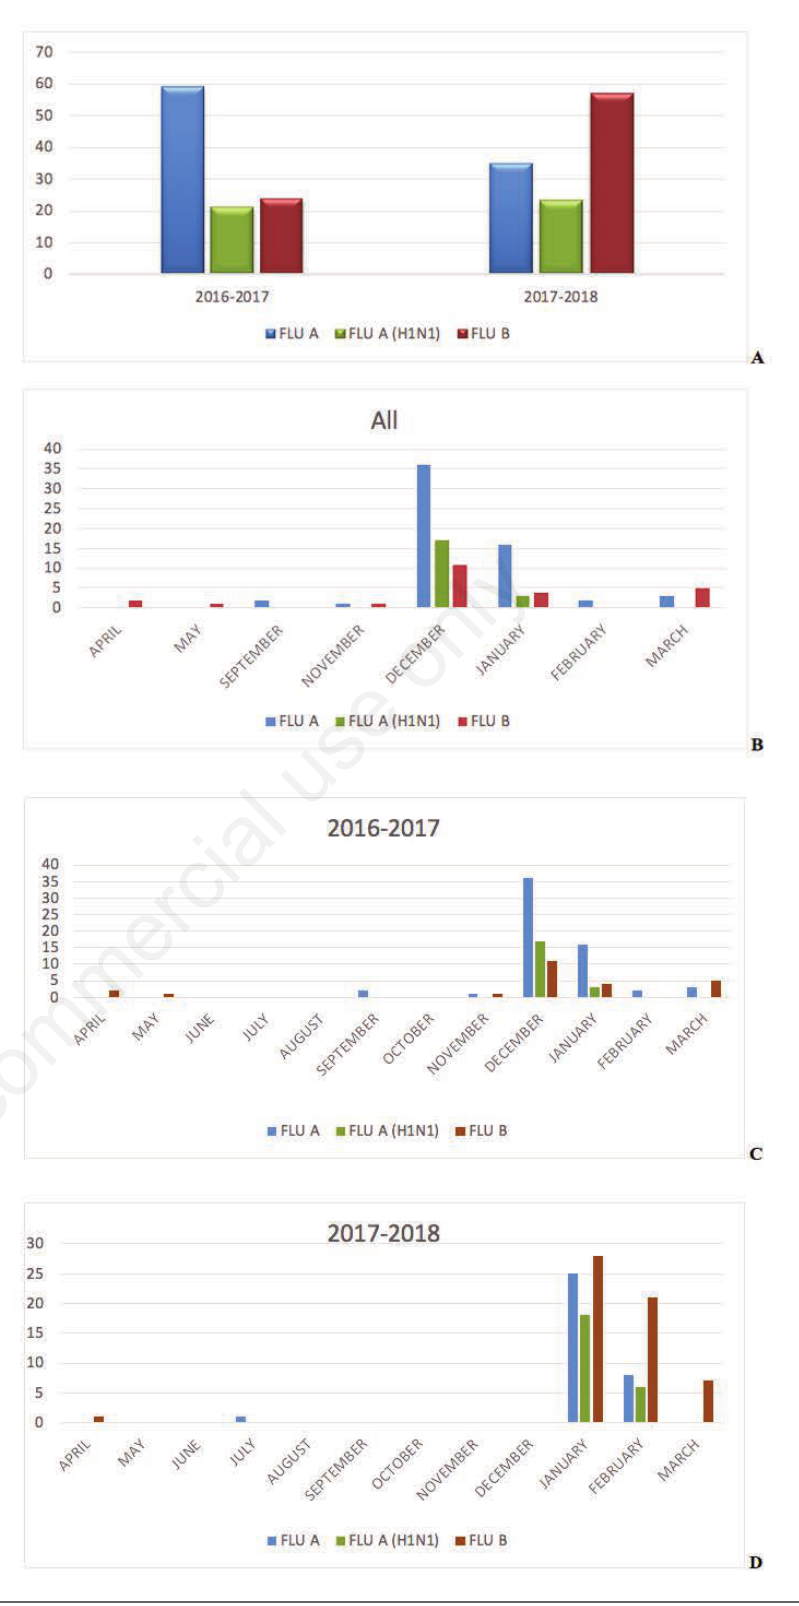
Figure 1. Frequency of samples positive to flu A, flu B and flu A (H1N1) during the influenza seasons 2016-2017 and 2017-2018. A) Overall frequency of Flu types in the two influenza seasons. B) Montly distribution of fluA, fluB and flu A (H1N1) cases in the whole study period; C) Montly distribution of fluA, fluB and flu A (H1N1) cases in